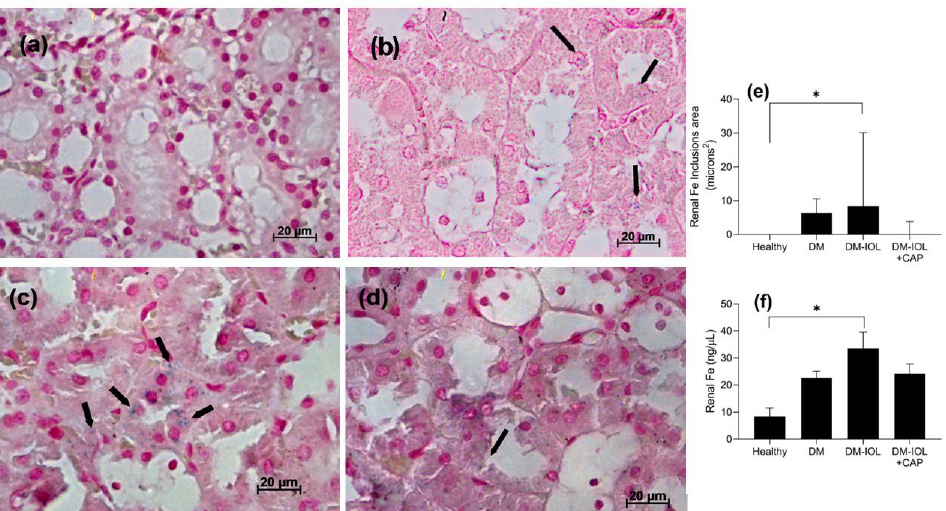
Figure 2. Representative images show that 12-week treatment with capsaicin (CAP, 1 mg·kg − 1 ·day −1 ) reduced iron deposits observed in the kidney tissues of rat groups with iron overload (IOL). ( Top row ) Iron deposits detected with stain (arrows) in kidney tissues from ( a ) healthy rats; ( b ) in rats with diabetes (DM) only; ( c ) in DM with IOL (DM-IOL); and ( d ) in DM with IOL + CAP (DM-IOL + CAP); ( e ) Areas of iron deposits measured in kidneys from each group with Perls’ Prussian blue staining; ( f ) Total iron content in kidneys. Images were acquired at 40 × with Axio Vision v.4.8. Scale bars: 20 µ m. Graphs show the mean ± standard error. * p < 0.05, ANOVA and post-hoc Bonferroni